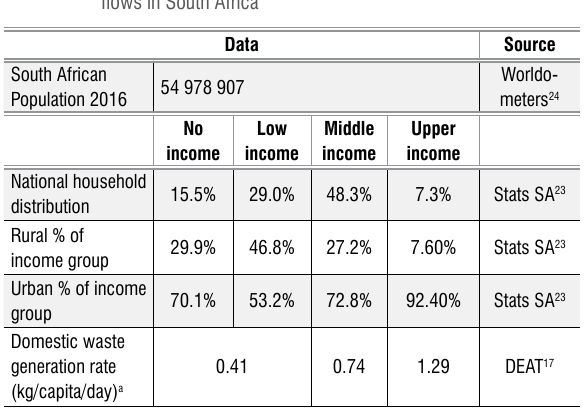
Key parameters for waste generation and population distribution as used in the model for the quantification of domestic waste flows in South